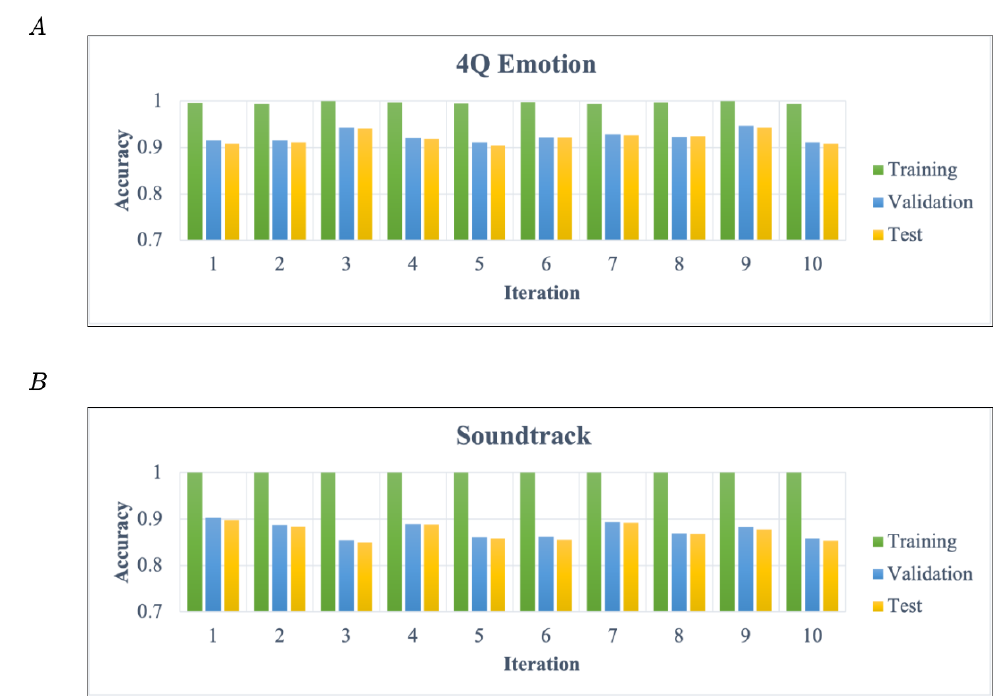
Figure 9. ( A ) represents the result of cross validation on the 4Q emotion dataset, and ( B ) shows the result of cross validation on Soundtrack. ( A , B ) are separated the individual dataset into ten times iteration to validate the model performance. The average of ( A ) (4 classes) is 92.07%, and the average of ( B ) (9 classes) is